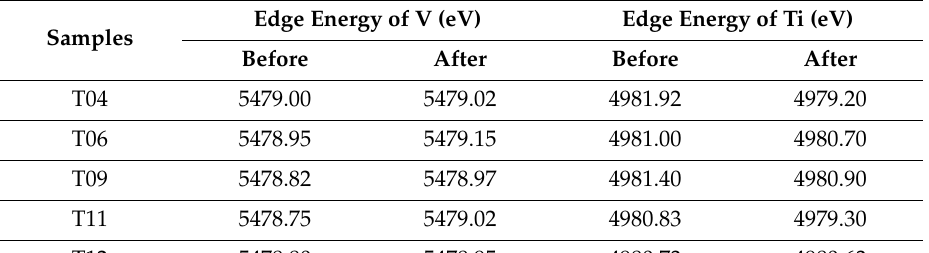
Table 3. Edge energy values of V and Ti obtained from K-edge X-ray absorption near edge structure (XANES) spectra of tanzanite samples before and after the heating experiment.